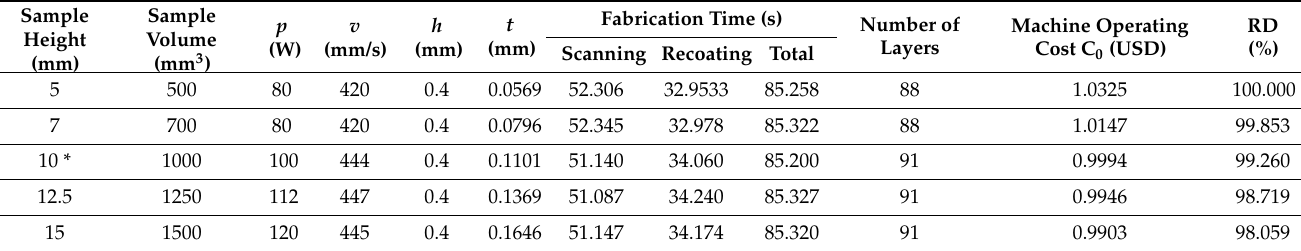
Table 8. Results of the variation in sample height with Model